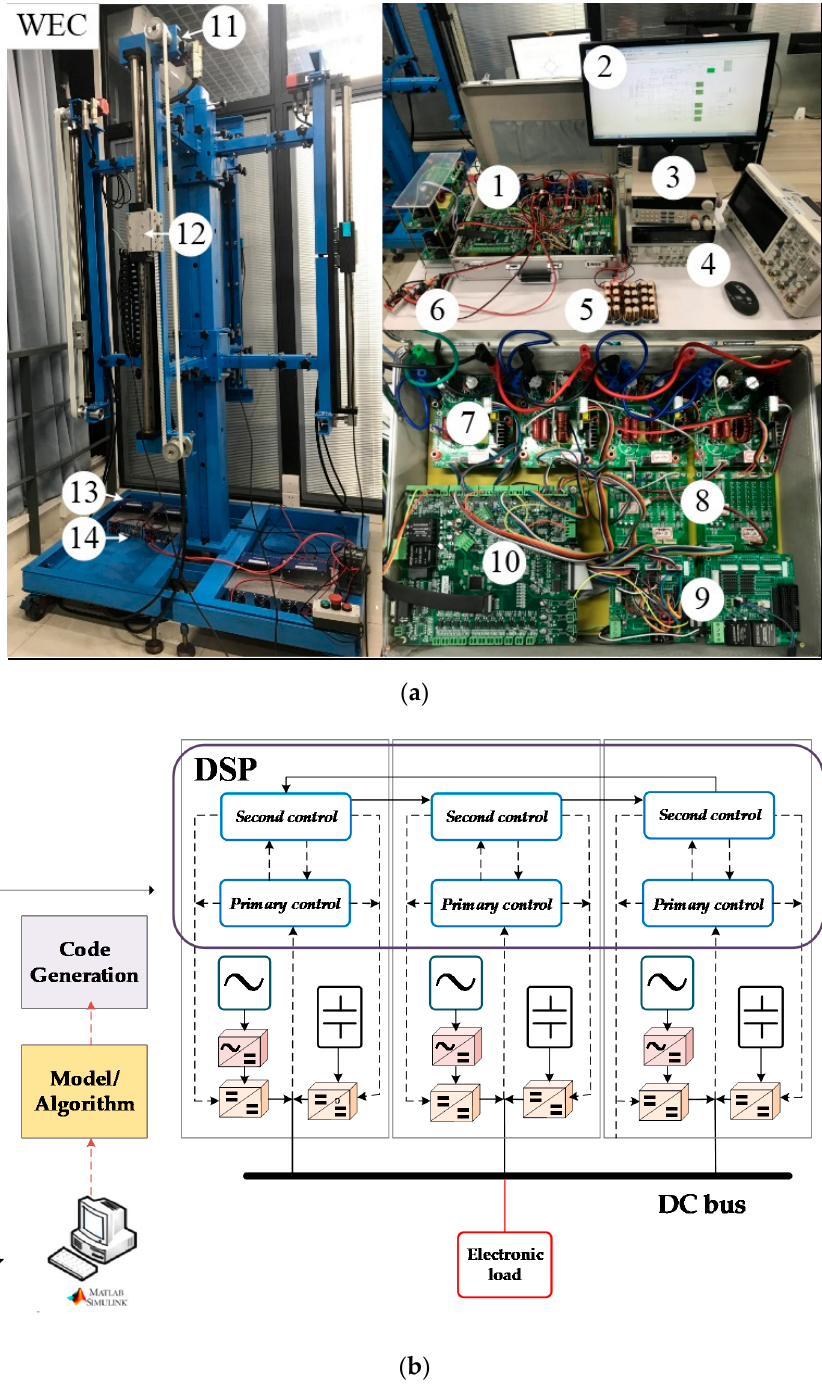
Figure 14. ( a ) Hardware structure: 1. Control board; 2. Computer. 3. Electronic load; 4. DC power; 5. Energy storage; 6. Rectifier; 7. Bidirectional converter; 8. Signal adapter board; 9. DC power; 10. DSP; 11. Rotating motor; 12. Translator; 13. Driver; 14. DC power; ( b ) Frame diagram of the experimental platform.